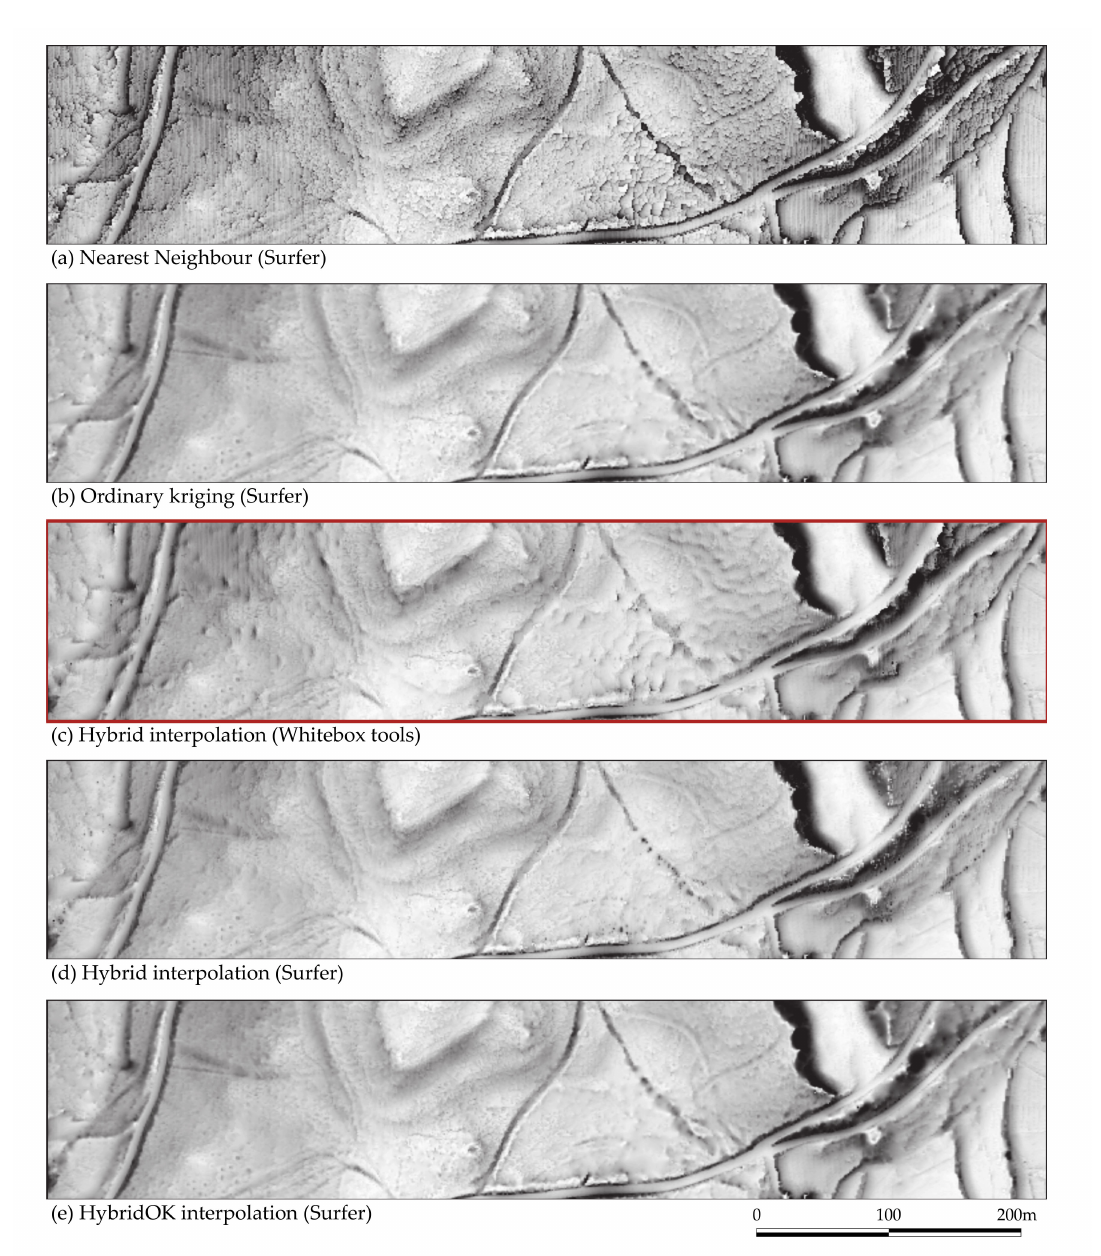
Figure 16. Test site ES, comparison of interpolations: ( a ) nearest neighbor (Golden Software Surfer 19.2.x); ( b ) ordinary Kriging (Golden Software Surfer 19.2.x); ( c ) hybrid (TLI and IDW calculated with Whitebox tools); ( d ) hybrid (TLI and IDW calculated with Golden Software Surfer 19.2.x); ( e ) hybridOK (TLI and ordinary Kriging calculated with Golden Software Surfer 19.2.x). The solution produced with the Open LiDAR toolbox is highlighted with a red